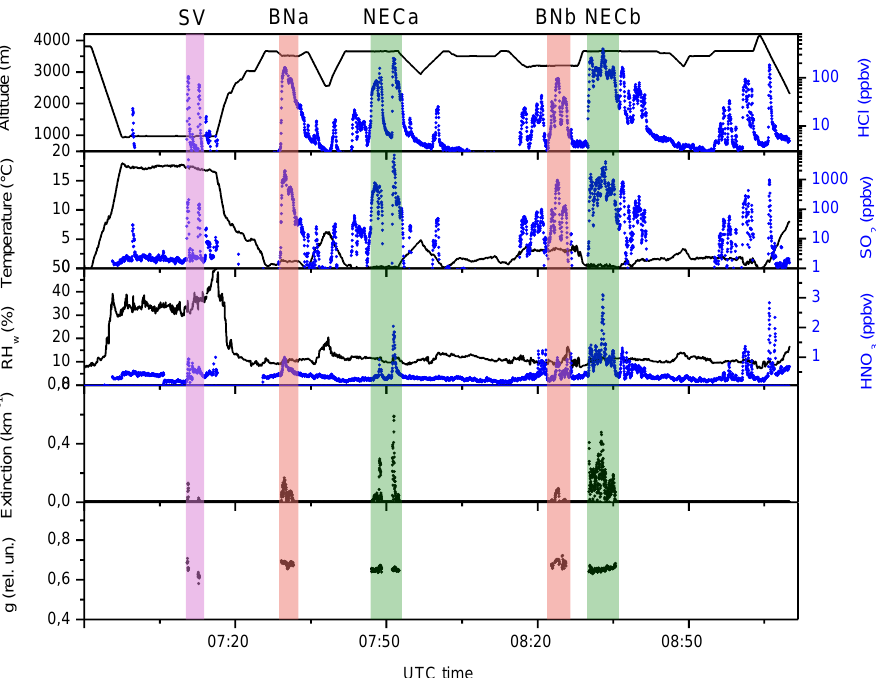
Figure 2. Aircraft observations of Stromboli and Etna plumes on 30 September 2011. Time series of altitude, air temperature ( T ) , relative humidity with respect to water (RH w ) , extinction coefficient (Ext), and asymmetry parameter ( g) are shown by black points. All these parameters are referred to the left-hand y axes. Time series of HCl, SO 2 , and HNO 3 mixing ratios are shown by blue points and referred to the right-hand y axes. Shaded areas labeled SV, BN, and NEC stand for plume samplings related to Stromboli, Bocca Nuova, and Northeast Etna craters,